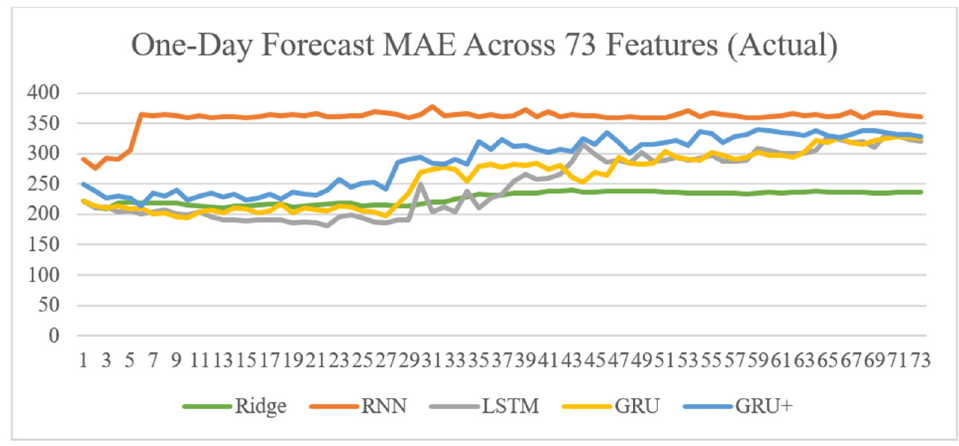
Figure 14. All RNN Models and Ridge One-Day Forecast MAE Across 73 Features (Actual). We show how the number of features affects the MAE score for one-day forecasting in the actual dataset.